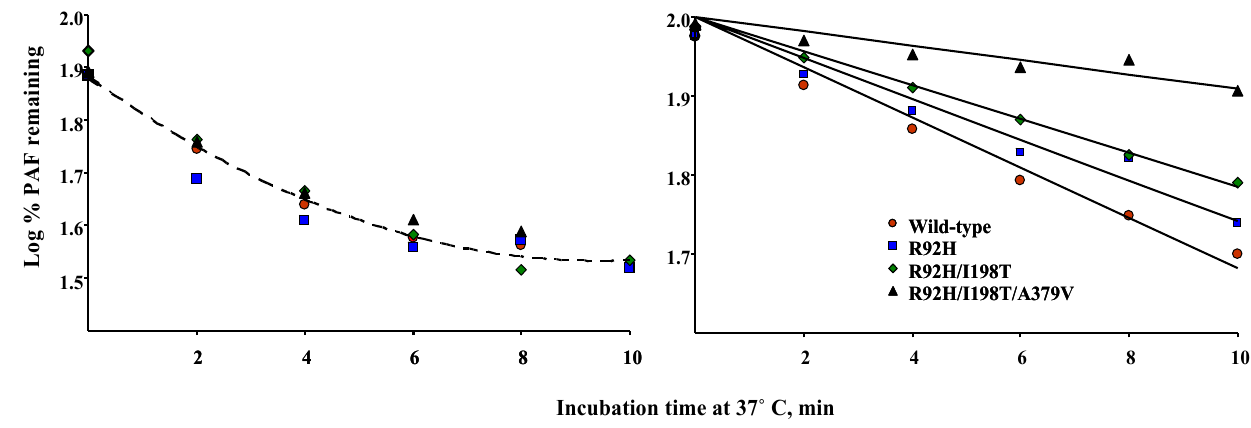
Figure 5. Kinetics of PAF (10 -9 M) hydrolysis by free (left panel) and LDL-associated (right panel) PAF-AH